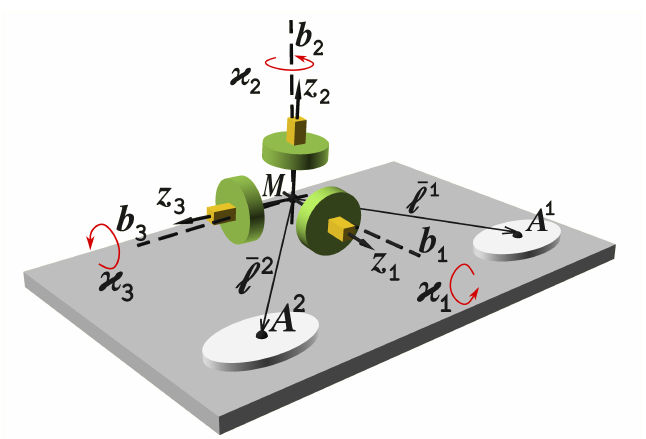
Figure 2. Sensor setup. Two antennas ( A 1 and A 2 ) of a dual-antenna GNSS unit reside at locations given by lever arms ¯ (cid:96) 1 and ¯ (cid:96) 2 relative to the inertial measurement unit with its reference point M . IMU instrumental axes z 1 , z 2 and z 3 are fixed to inertial sensor array, while lever arm vectors are known in a carrier body reference frame. Three components κ 1 , κ 2 and κ 3 of the Euler rotation vector define the slight misalignment between the two reference frames. Table 1. General